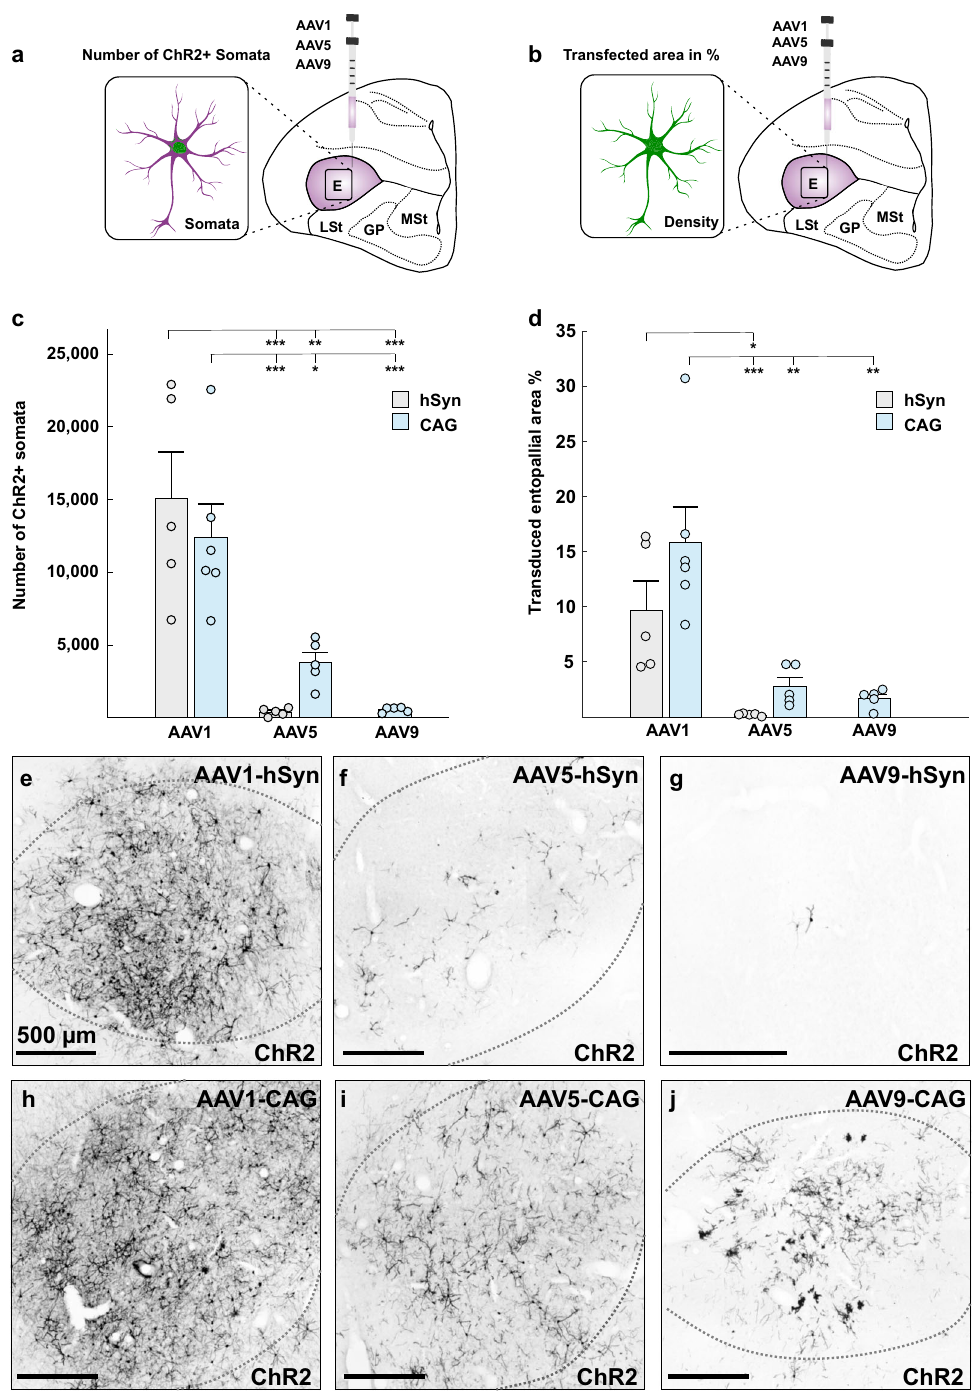
Fig. 1 Comparative transduction analysis of AAV1, AAV5, and AAV9 in combination with the hSyn and CAG promoters. a Schematic illustration of the injection area and analysis type. For the fi rst analysis, all somata were counted that displayed ChR2 expression. b Schematic illustration of the injection area and the analysis type. For the second analysis, the area of ChR2 expressing somata, dendrites, and axons was measured and compared to the total area of the entopallium. c Quantitative comparison of all tested constructs in their ability to drive transgene expression in somata of the entopallium. AAV1-hSyn- ChR2, as well as AAV1-CAG-ChR2, were signi fi cantly more ef fi cient than all other tested constructs. d Percentage of ChR2 expressing entopallial area for all tested constructs. AAV1-CAG was signi fi cantly more ef fi cient than all other tested constructs. All AAVs with hSyn promoter are depicted in gray and all AAVs with CAG promoter are depicted in blue. e – j Qualitative pictures of ChR2 expression following injections of e AAV1-hSyn-ChR2 ( n = 5), f AAV5- hSyn-ChR2 ( n = 5), g AAV9-hSyn-ChR2 ( n = 5), h AAV1-CAG-ChR2 ( n = 6), i AAV5-CAG-ChR2 ( n = 5), and j AAV9-CAG-ChR2 ( n = 5). All scale bars represent 500 µ m. Error bars represent the standard error of the mean (SEM) and dots represent the raw data, *** p < 0.001, ** p < 0.01, * p < 0.05. Abbreviations: AAV adeno-associated viral vector, hSyn human synapsin 1 gene promoter, CAG chicken beta-actin